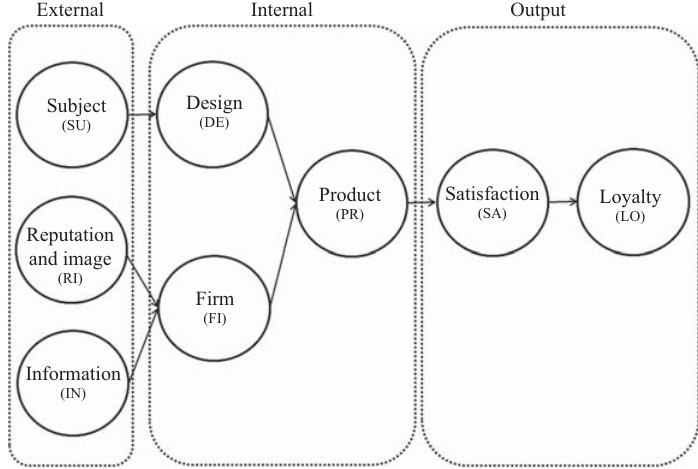
Figure 2. Grouping of variables in